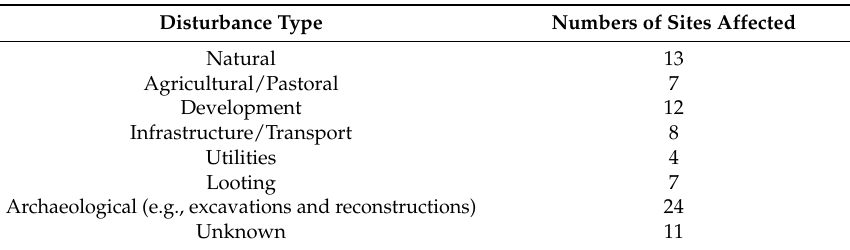
Figure 9. Unsupervised classifications (represented in 3 colours) highlighting the urban areas around Cyrene produced from a Landsat 5 image (1986), a Landsat 7 image (2000), and a Sentinel-2 image (2017). The background is the Sentinel-2 image (2017). Table 6. Disturbance types logged at Cyrene.